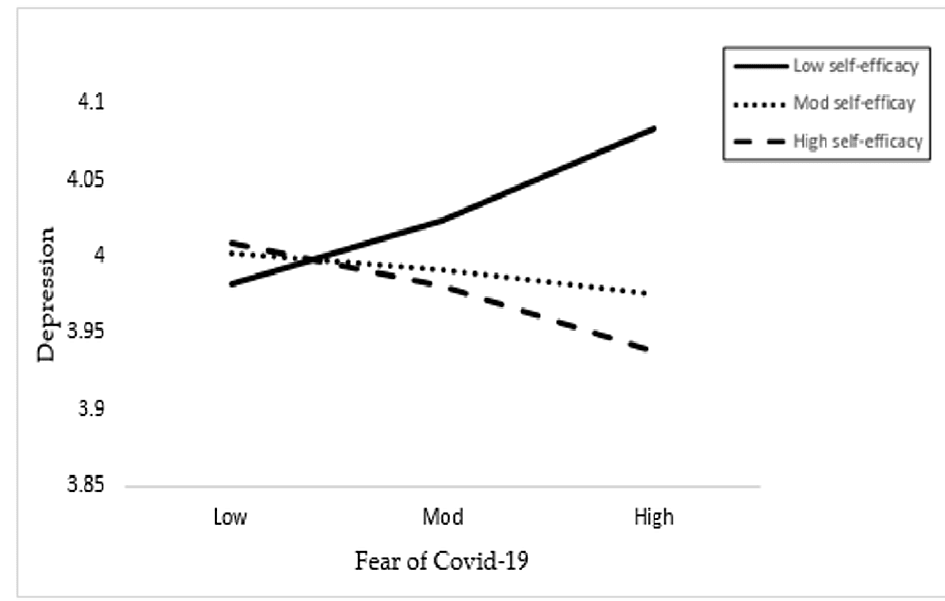
Figure 2. Interactive effect of the fear of COVID-19 and self-efficacy on depression.